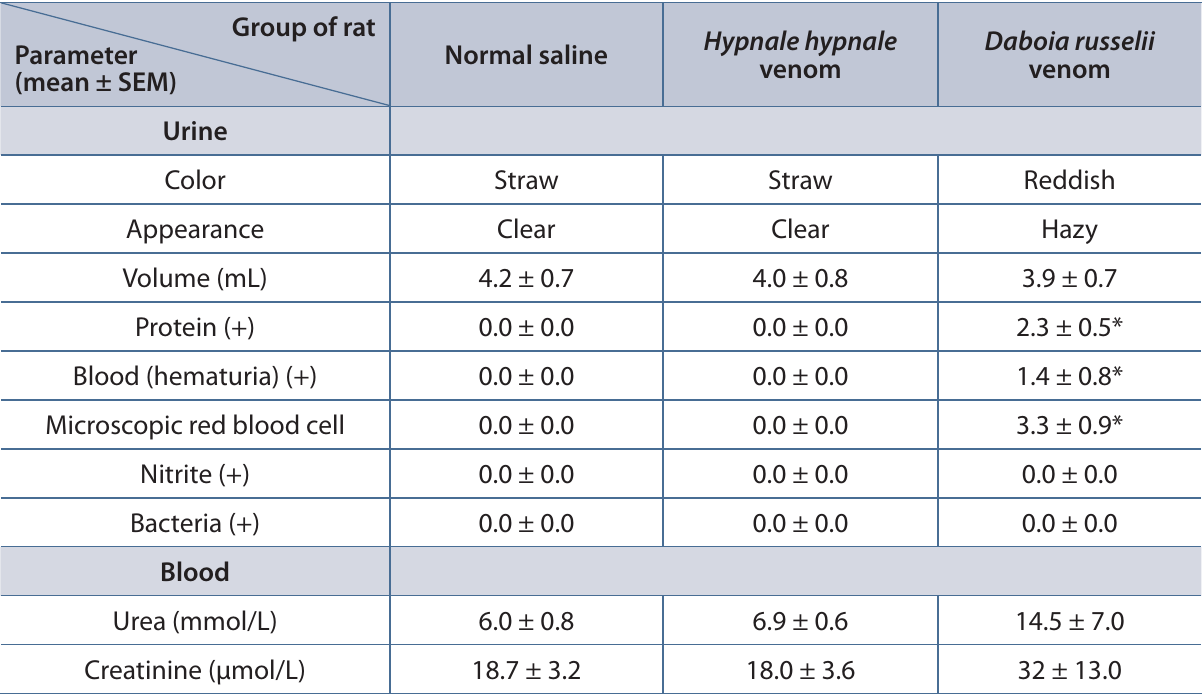
) of H. hypnale and D. russelii venoms on blood 50